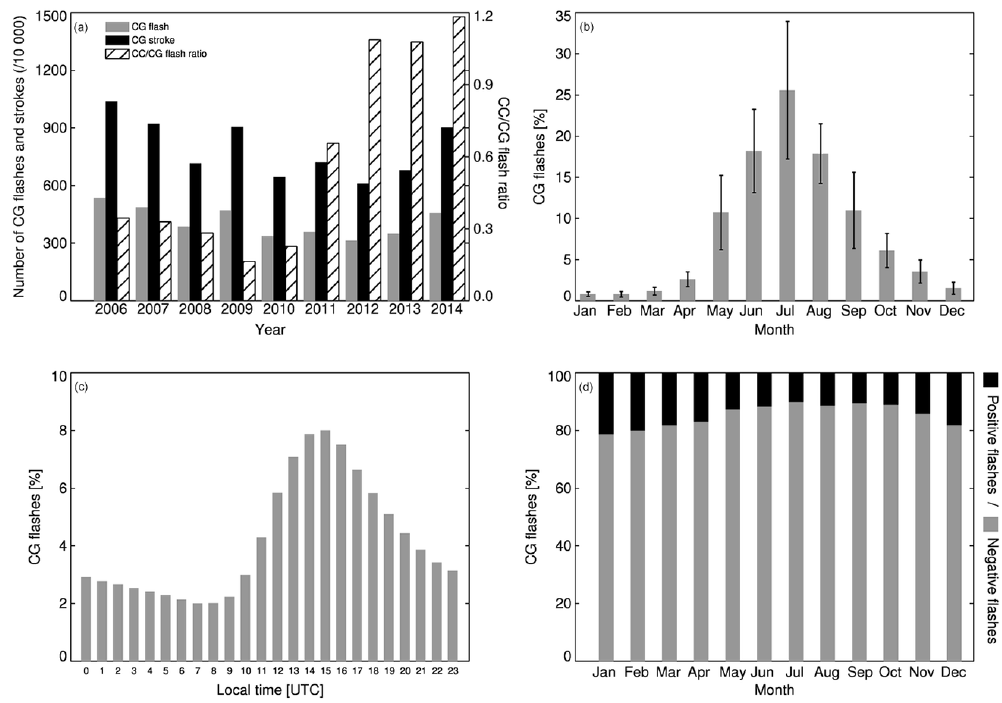
Figure 2. (a) Variation of the annual CG stroke and flash counts, as well as the CC/CG flash ratio, (b) mean monthly flash counts with bars representing the ± 1SD (standard deviation), (c) mean diurnal flash counts and (d) mean monthly polarity distribution, based on 2006–2014 EUCLID